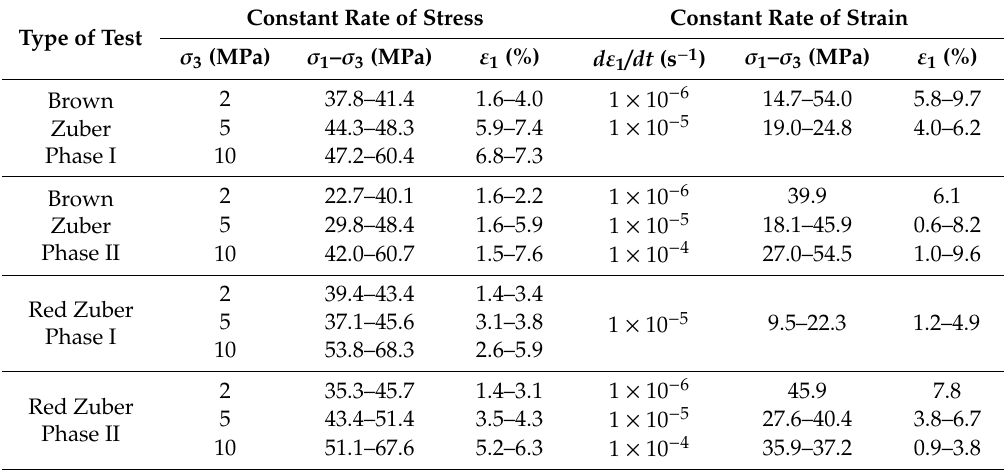
Table 2. Maximum values of di ff erential stress ( σ 1 – σ 3 ) and axial strain ( ε 1 ) obtained in the conventional triaxial compression tests.